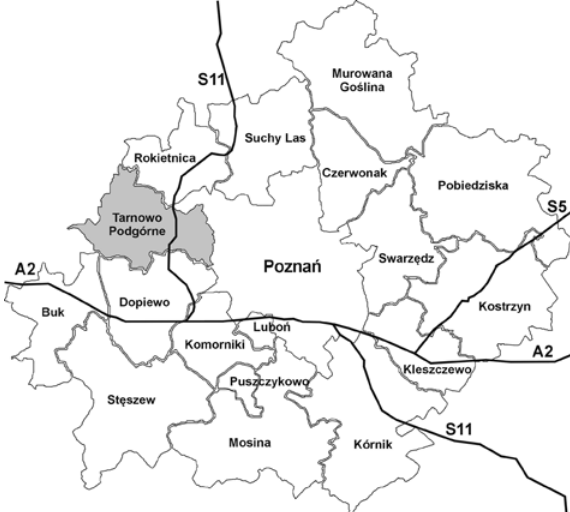
Fig. 2. Location of Tarnowo Podgórne commune in the suburban zone of the city of Poznań against the administrative division and the road network. Source: own